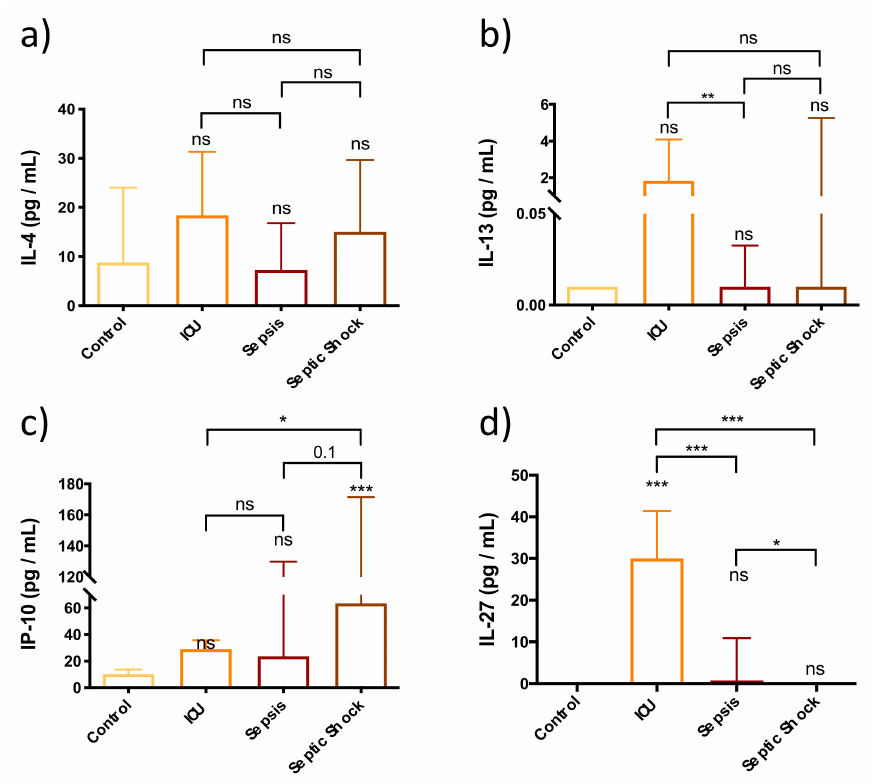
Figure 5. Bar graph (Median ± IQR) of circulating levels of adaptive immune mediators in control, ICU, sepsis and septic shock patients. ( a ) Circulating levels of IL-4; ( b ) Circulating levels of IL-13; ( c ) Circulating levels of IP-10; ( d ) Circulating levels of IL-27. Each sample was measured in duplicate. ns = non-significant p value; * p < 0.05; ** p < 0.01; *** p < 0.001. The lines at the top of the box plots indicate differences between compared conditions. The number of subjects analyzed were as follows: control ( n = 10); intensive care unit (ICU) ( n = 5); sepsis ( n = 10); septic shock (SS) ( n = 15).